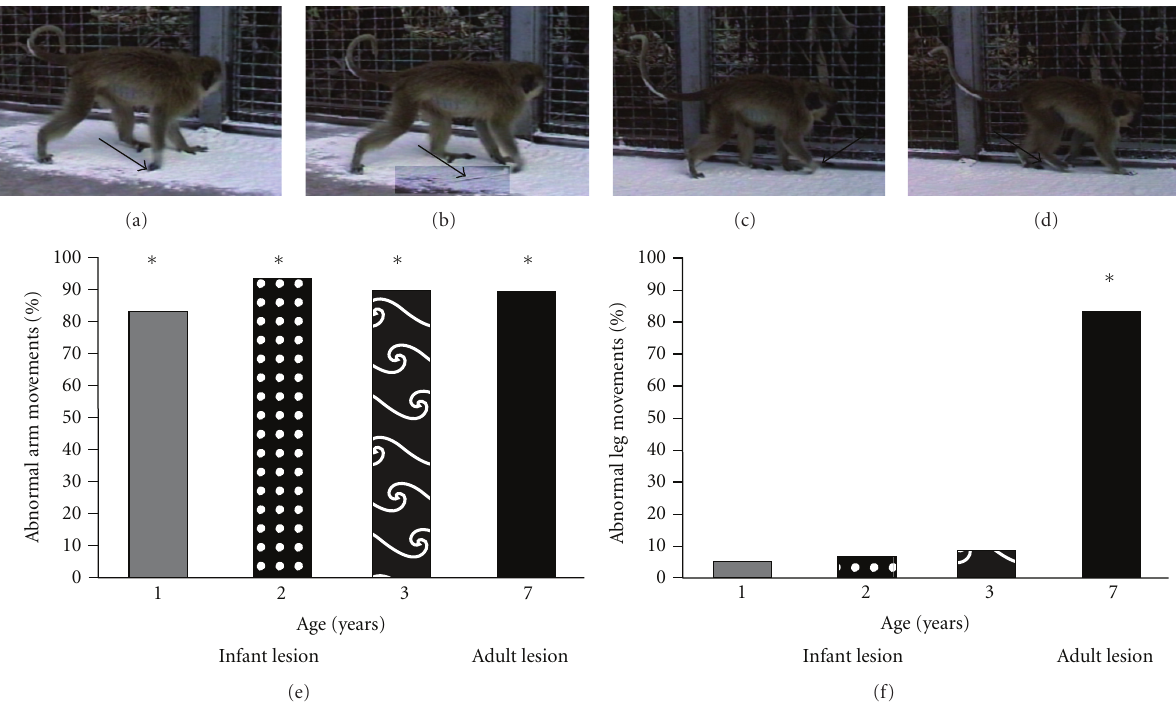
Figure 3: Normal gait was significantly a ff ected by the removal of one hemisphere. The ipsilateral side of the body acts as a control for normal motor movements and did not show any paresis, also referred to as the nonparetic side of the subject. Panels (a)–(d) are indicative of a typical gait sequence. As the forelimb moves forward, the contralateral appendages drag on the ground (arrow panel a). The hand dragging continues through the entire forward motion (arrow panels b and c). The hind limb is fully removed from the ground and does not drag (arrow d). At each time point and lesion group there is a significant e ff ect of the hemispherectomy on upper limb movement defined as arm drags/total forward arm movements (e). A number of abnormal leg movements (drags and limps) as a percentage of total leg movements was significantly elevated over the expected rate of zero in the adult-lesioned group only (f). Years 1, 2, and 3 refer to the age of the infant- lesioned subjects at testing which also corresponds to the years after lesion. For the adult-lesioned subjects, testing occurred 3 years after initial surgery when the subjects were 7 years old. ∗ P < 0 . 001 adapted from